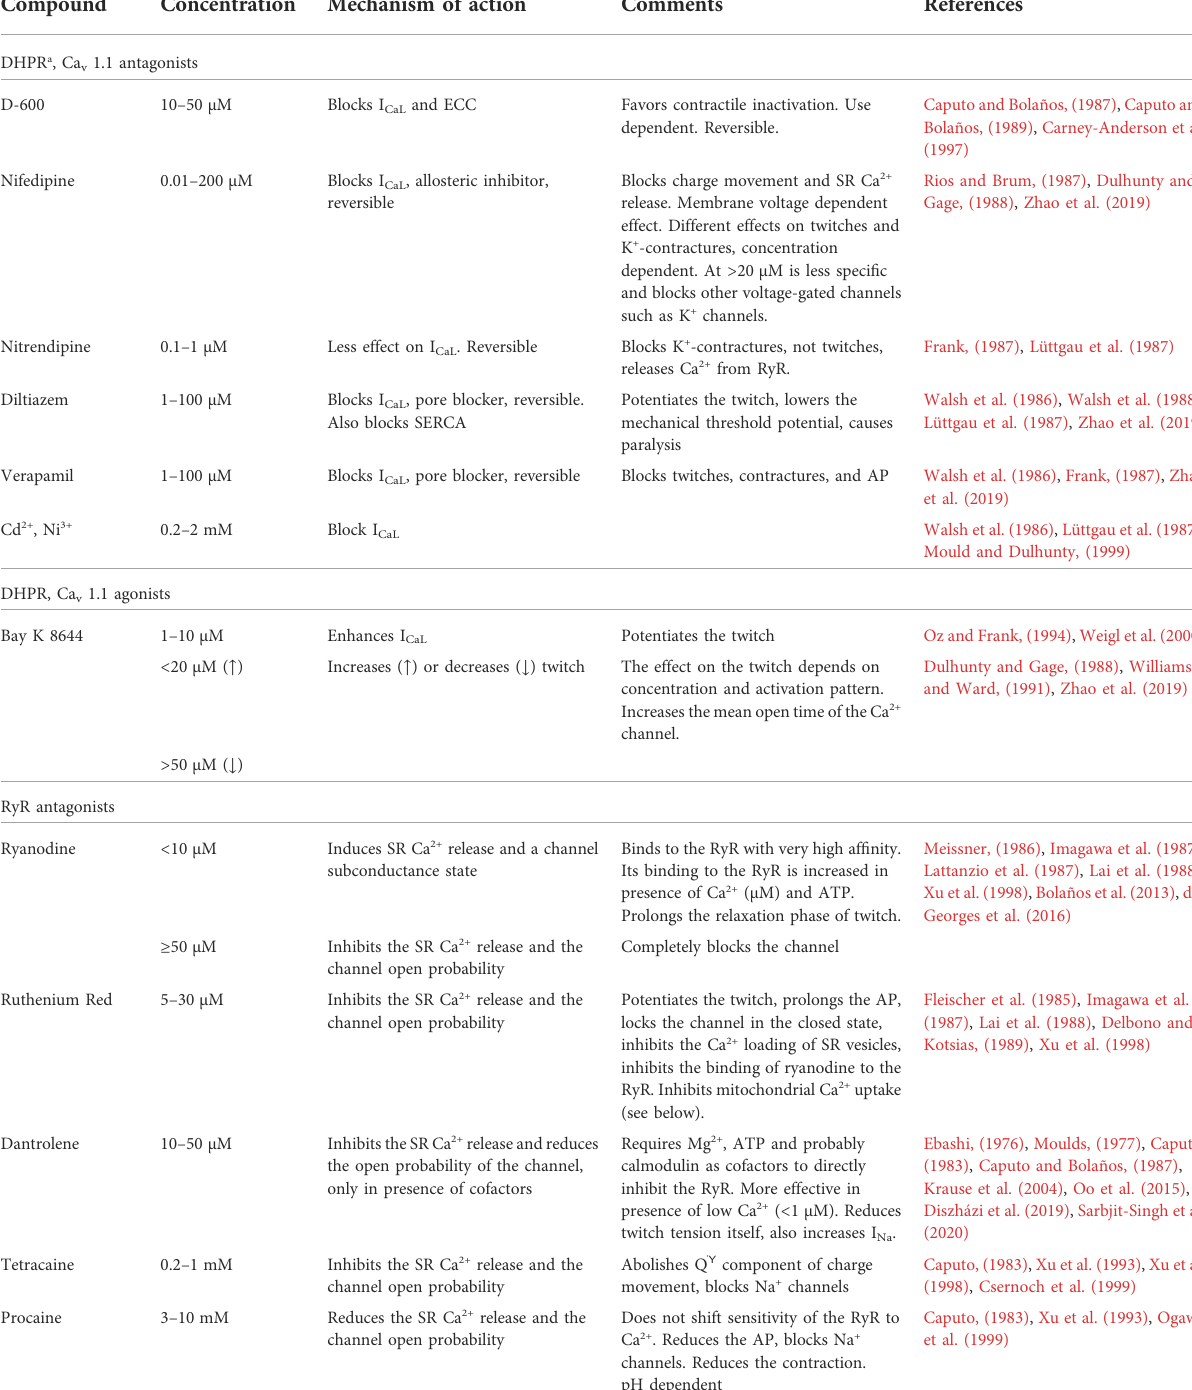
TABLE 2 Pharmacology of the ECC in skeletal